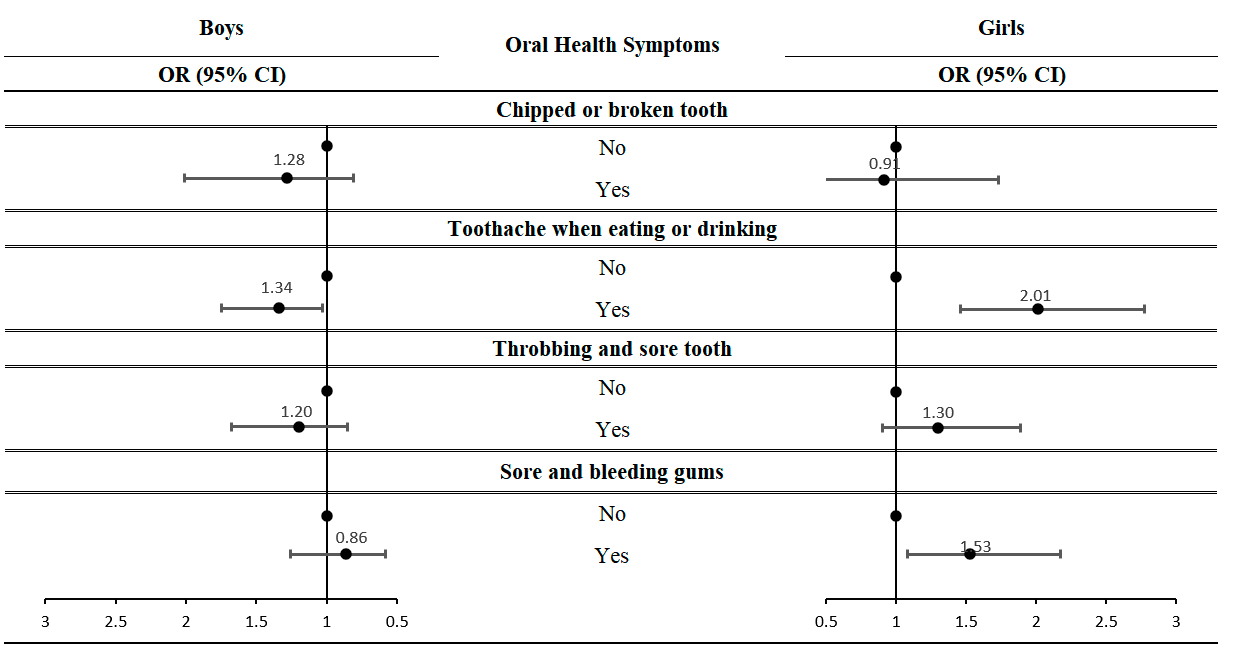
Figure 1. Association of oral health symptoms with asthma, with non-asthma students as the reference category.